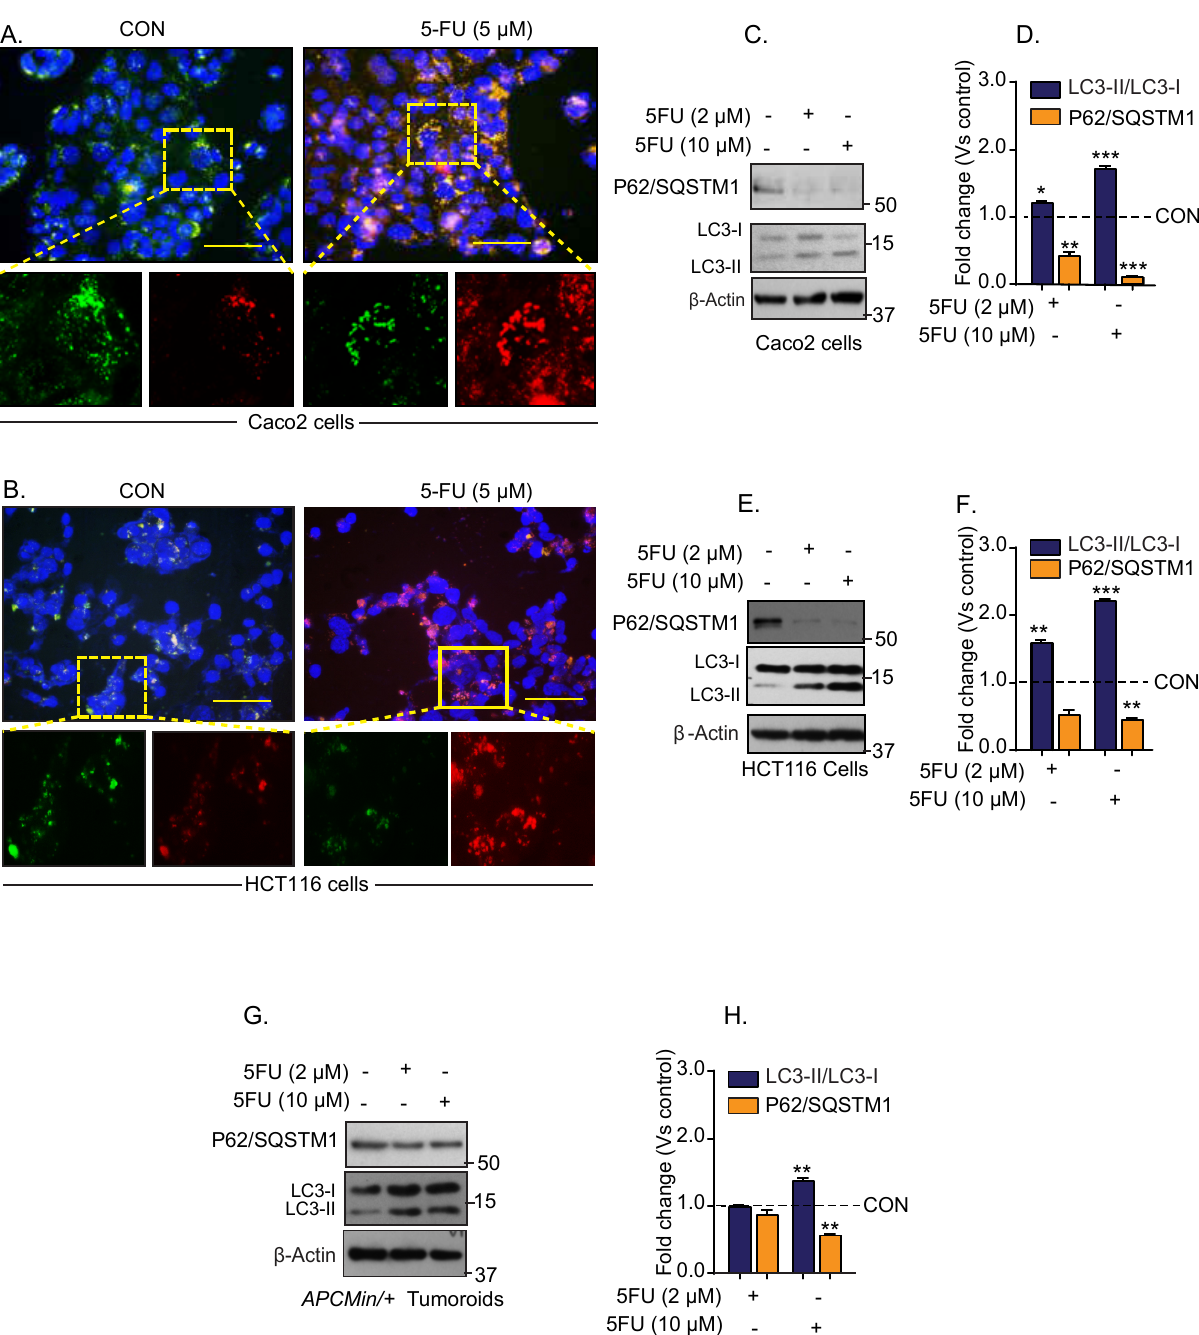
Figure 1 . Conventional first-line colon cancer therapy drug 5-FU treatment induces autophagy in colon cancer cells. Caco-2 and HCT116 cells expressing GFP-LC3-RFP-LC3ΔG reporter expression construct were treated with 5-FU (5 µM) for 24 h. ( A ) Representative images of GFP- and RFP-positive Caco-2 cells; ( B ) representative images of the GFP- and RFP-positive HCT116 cells; ( C – H ) representative immunoblotting for P62/SQSTM1 and LC3-I and LC-II expressions, and densitometric analysis. Autophagy flux was evaluated by the densitometric analysis of LC3-II/LC3-I expressions. Statistical significance was determined by Student’s t -test. *** p < 0.001, ** p < 0.01, * p < 0.05. Scale bar = 50 µM.